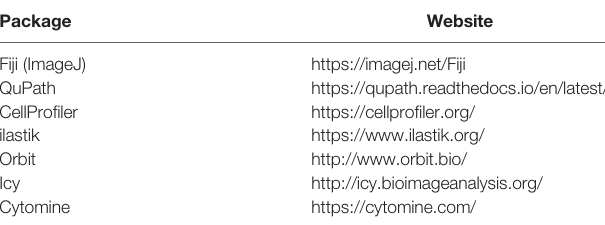
TABLE 3 | Representative open source digital image analysis software packages. TABLE 1 | Examples of immune cells phenotypes according to their positive